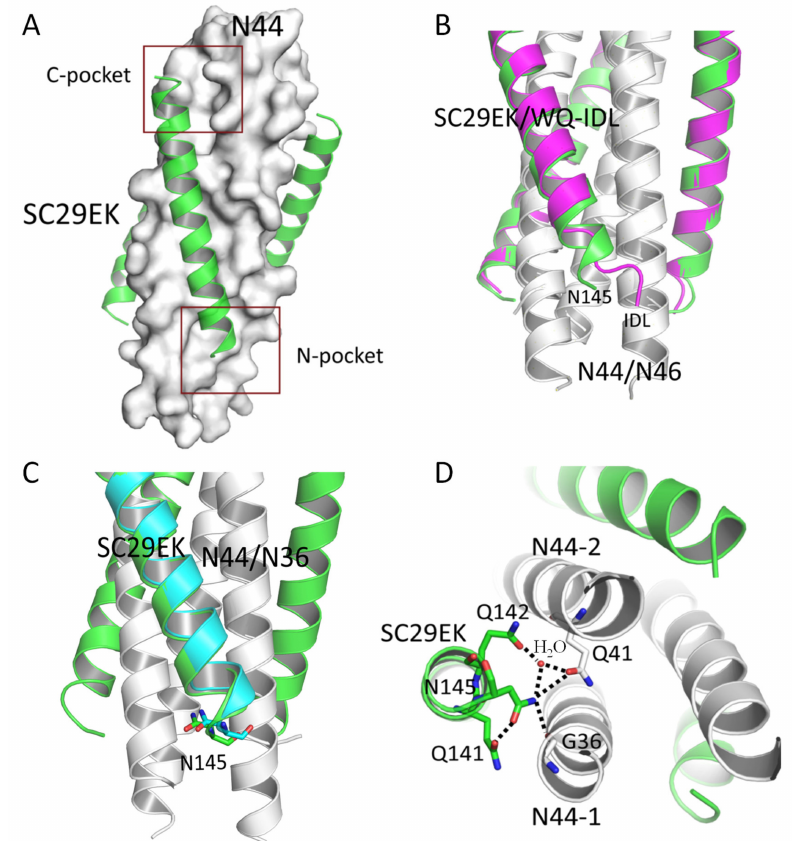
Figure 9. Structural basis of Asn-145-mediated binding network in SC29EK inhibitor. ( A ) The 6-HB structure of the SC29EK / N44 complex. The N44 trimer is shown in surface and colored in gray, with the C-terminal deep pocket (C-pocket) and the N-terminal shallow pocket marked; SC29EK inhibitors are shown in ribbon and colored in green. ( B ) Superimposing of the SC29EK / N44 structure with the WQ-IDL / N46 structure (PDB accession number 5H0N). SC29EK inhibitors are in green with a marked Asn-145 residue, WQ-IDL inhibitors are in magenta with a marked IDL anchor. ( C ) Superimposing of the SC29EK / N44 structure with the SC29EK / N36 structure (PDB accession number 5Z0W). SC29EK